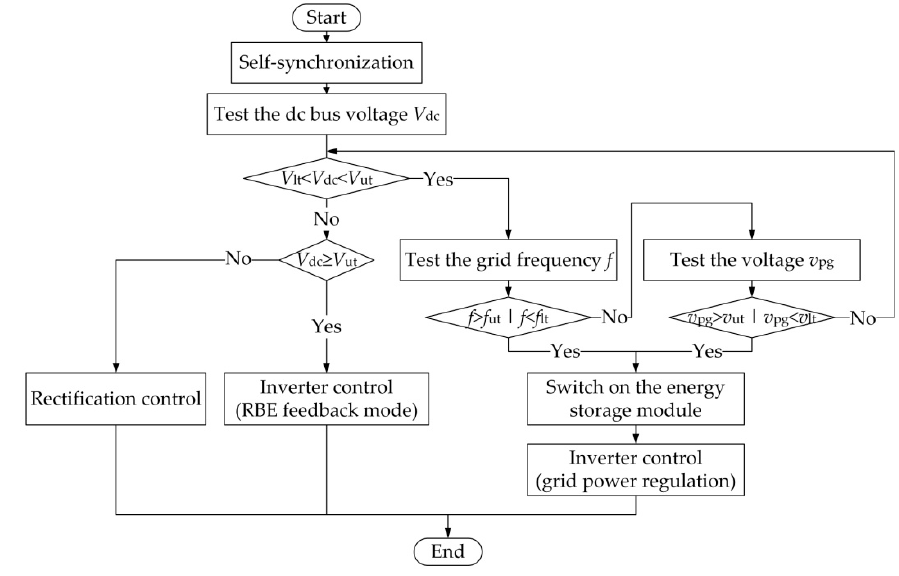
Figure 7. Overall control strategy of the master controller.